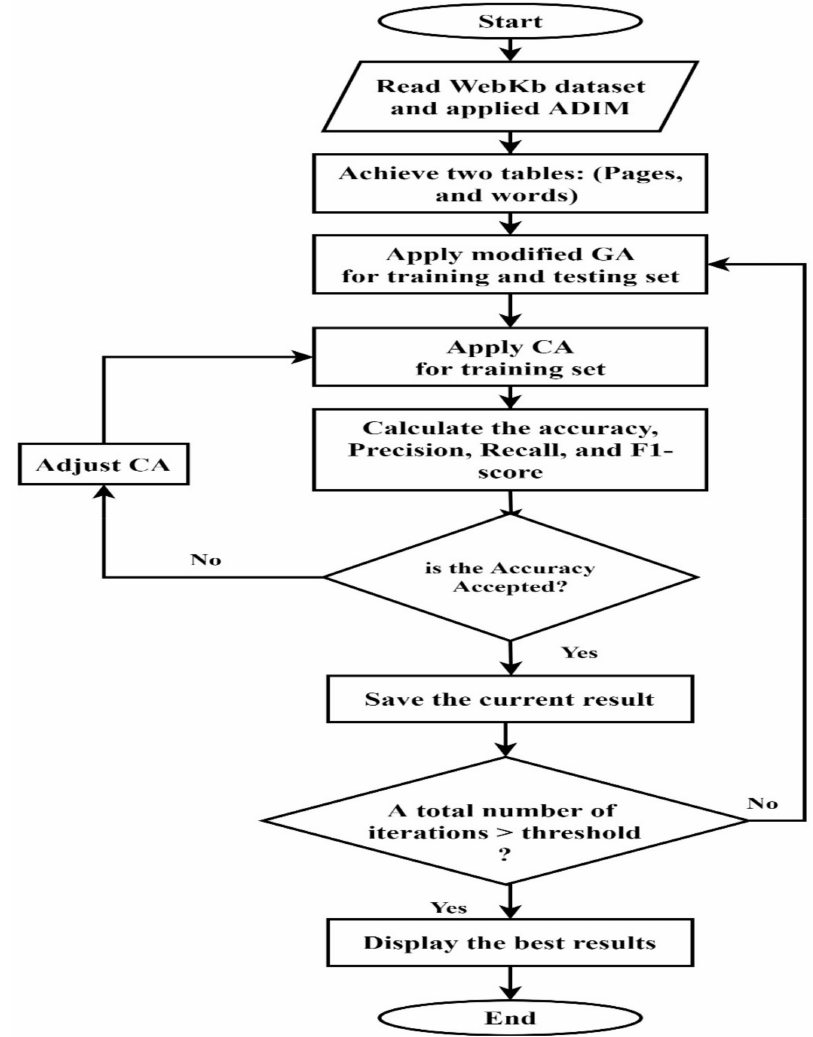
Figure 8. General flowchart of the presented integration